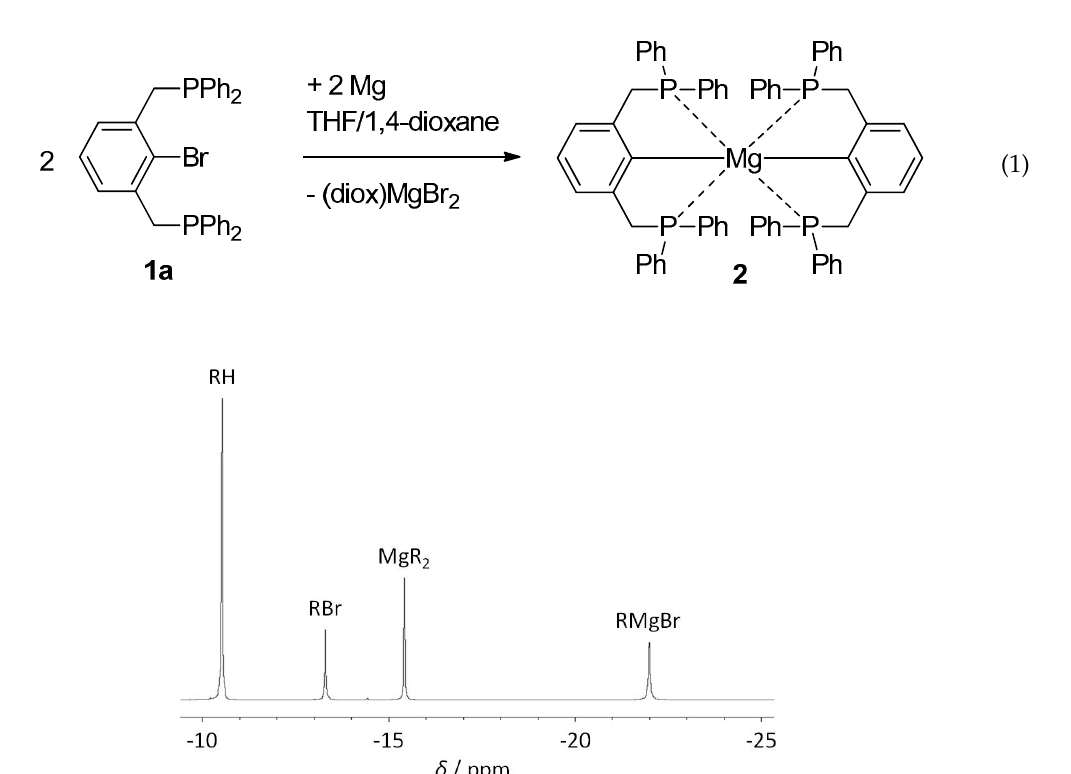
Figure 1. 31 P{ 1 H} NMR spectrum of the Grignard reaction of bromo-2,6-bis(diphenylphosphanyl- methyl)benzene ( 1a , RBr) with magnesium in tetrahydrofuran (see text, R = C 6 H 3 -2,6-(CH 2 PPh 2 ) 2 ; 162